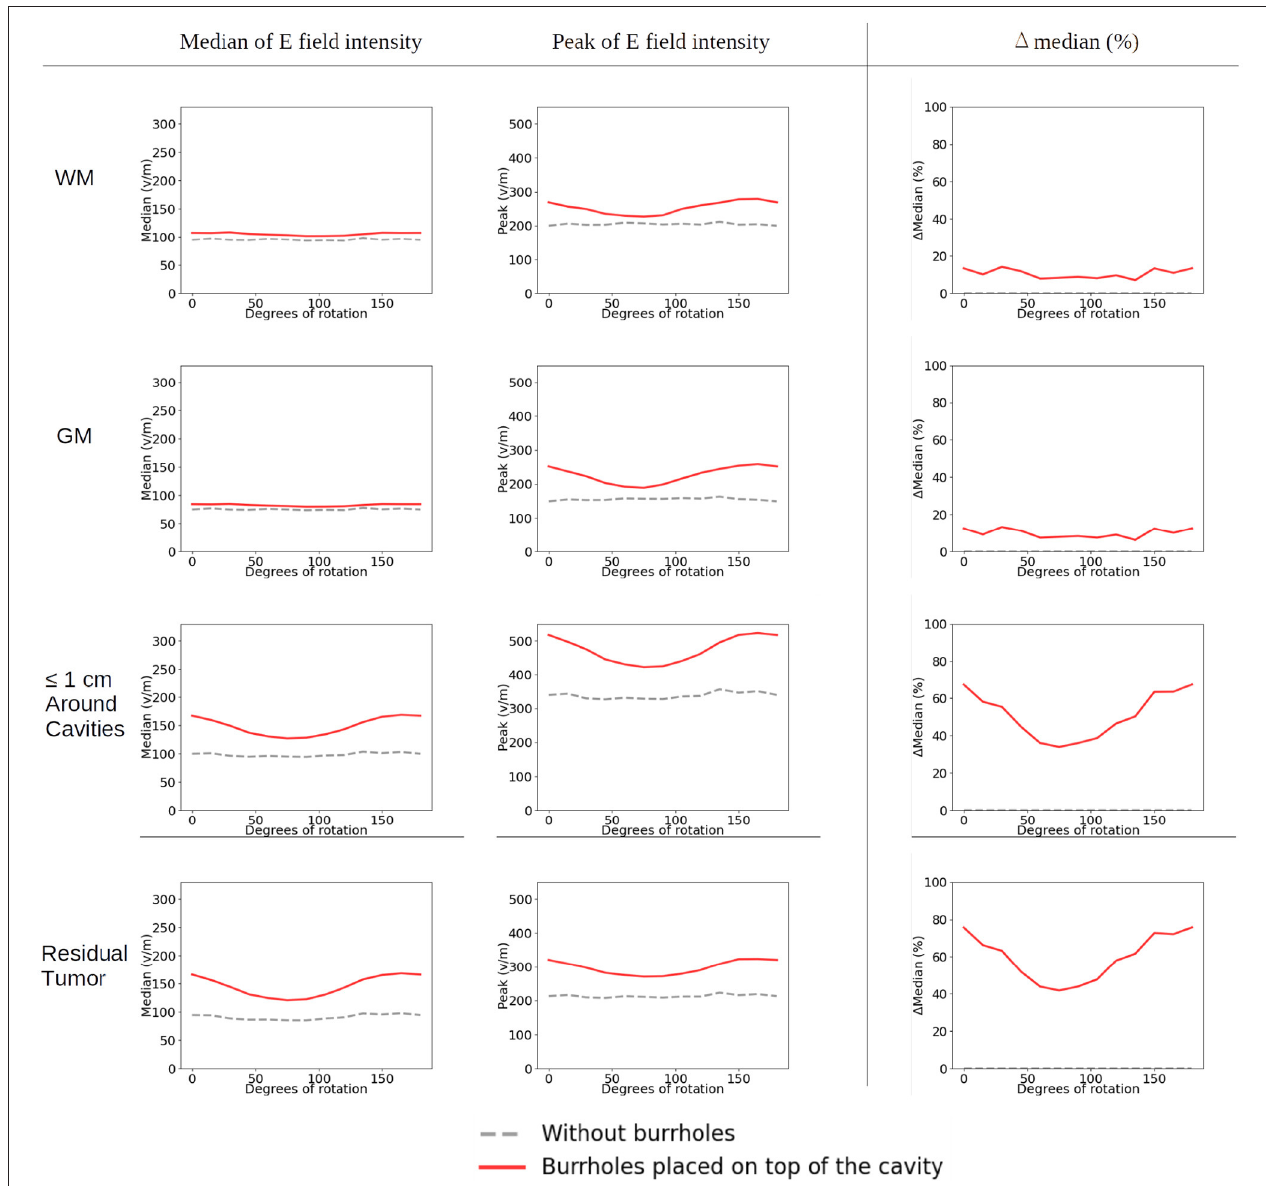
FIGURE 9 | Statistical analysis of TTFields intensities with burr holes directly over the resection cavity and residual tumor (solid red lines) and without burr holes (dashed gray lines). The x -axis shows the rotation degrees of the ipsilateral array around the axis normal to the skin surface at the center of the array ( Figures 4B , 10 ). The y -axis shows the field strength. The first two columns represent the median and peak values of TTFields intensities for the four tissue types (WM, GM, peri tumor and residual tumor). The last column shows the field intensity enhancement when SR-surgery is performed. The TTFields intensities of WM and GM are similar with or without burr holes. The field intensity in the peri tumor and the residual tumor decreases with electrodes with no/little overlap with the burr holes, corresponding to 60–105